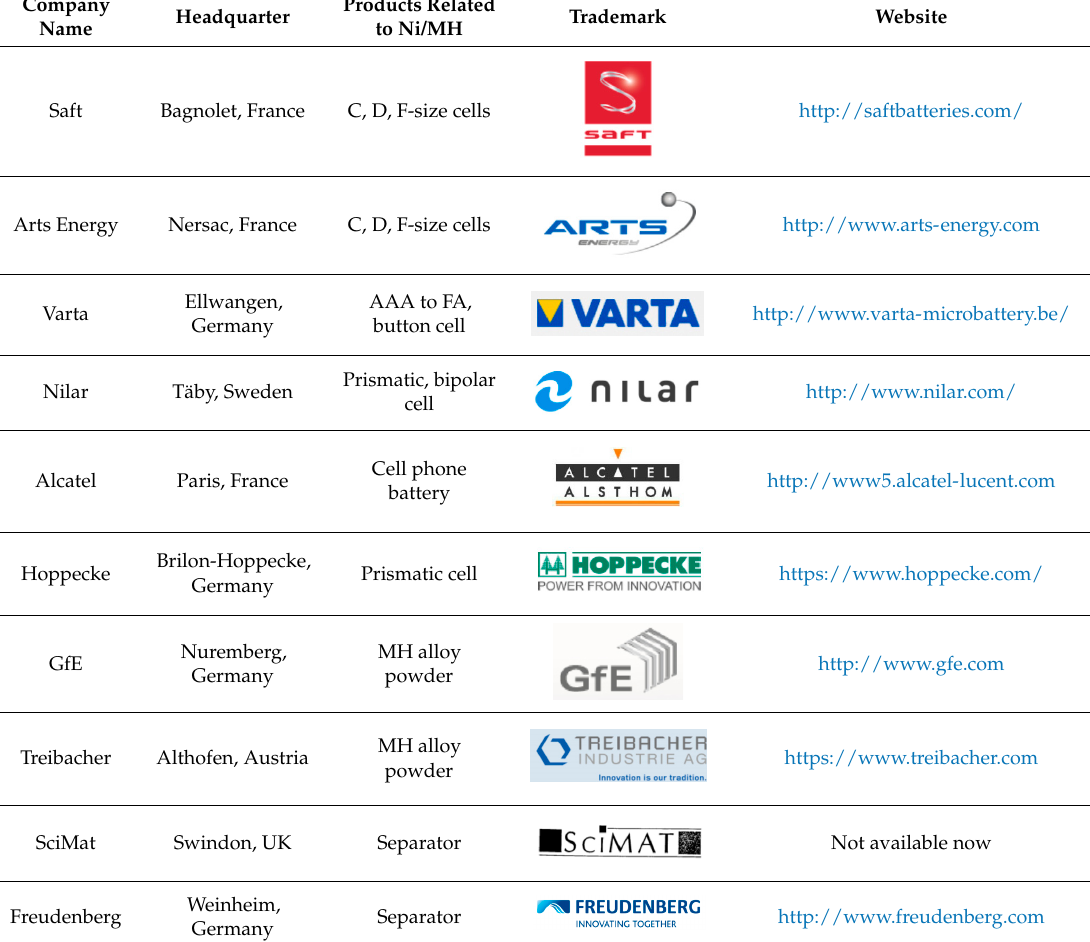
Figure 1. Consumer Ni/MH battery market shares for ( a ) Sources in 2013, ( b ) Exports from China in 2013, and ( c ) Exports from Japan in February 2014. Data originate from [2]. Table 1. European companies related to Ni/MH battery manufacturing included in this review, in order of their presence.